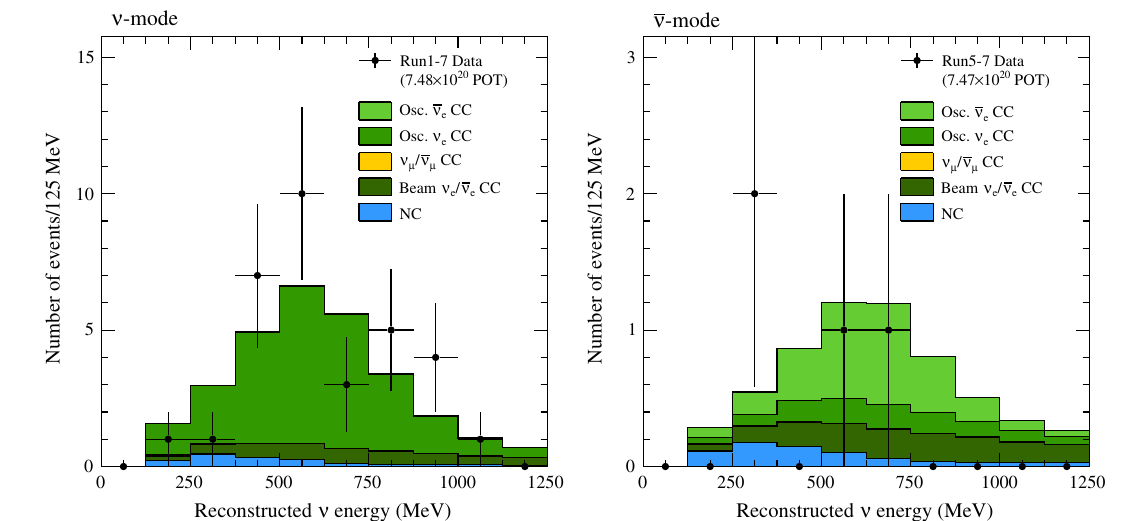
Fig. 67 Reconstructed neutrino energy distributions of electron neu- trino events in neutrino beam mode (left) and anti-neutrino beam mode (right) assuming CC QE interaction kinematics. The data are shown as